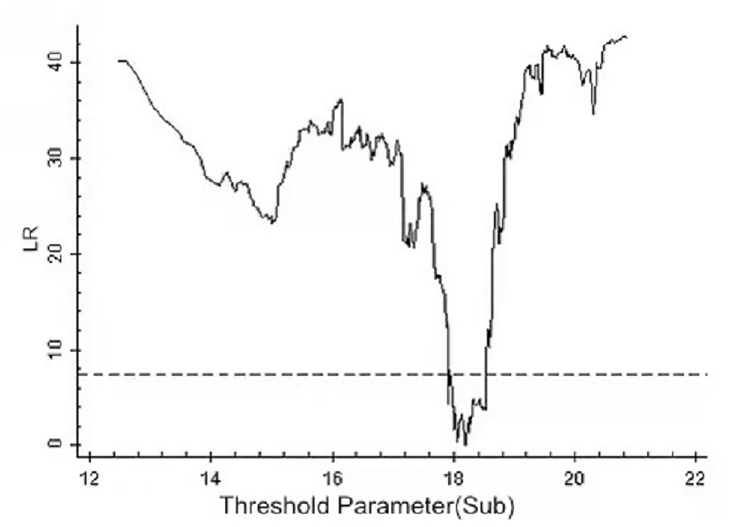
Fig 5. Estimated value and confidence interval of the first threshold in Model 3.